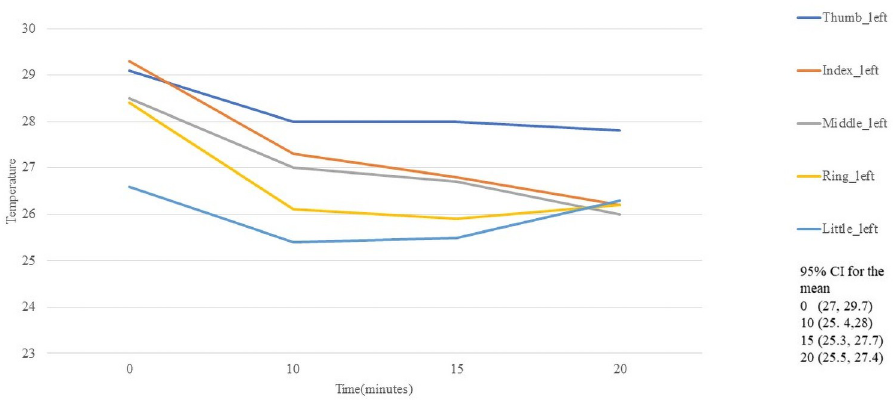
Fig 8. Temperature behaviour of the fingers in palmar left